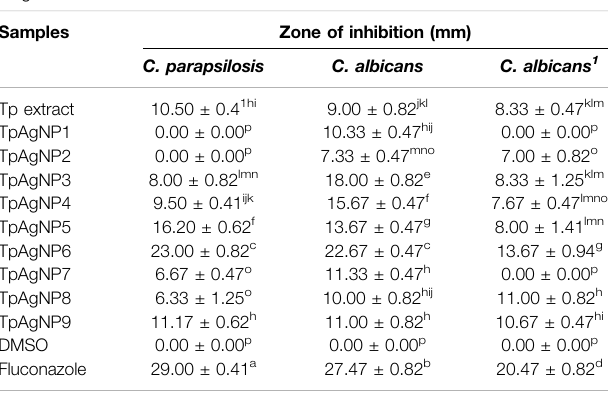
TABLE 5 | Zone of inhibition of plant extract and TpAgNPs of T. pallida against fungal strains.